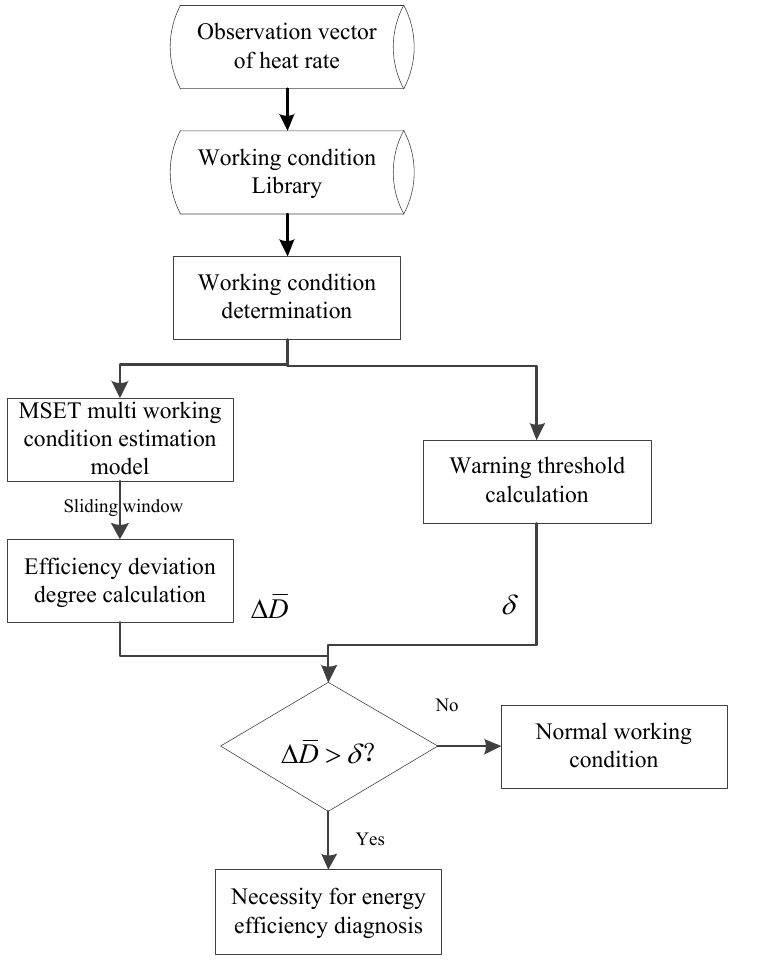
Figure 11. Flow chart of energy efficiency monitoring method. Table 5. Partial sample data for energy efficiency